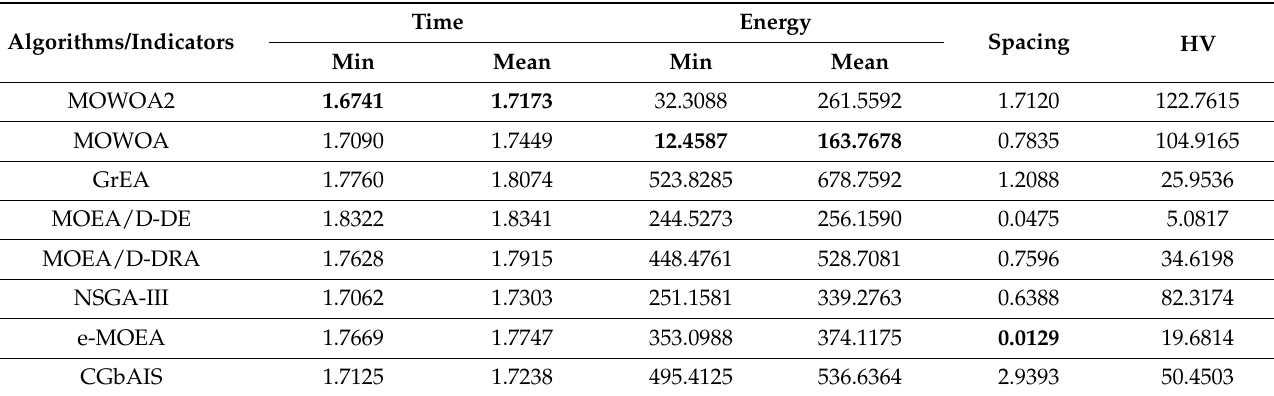
Table 4. The values of indicators using different algorithms when the user number is 45. The bold number is the best value in this column.